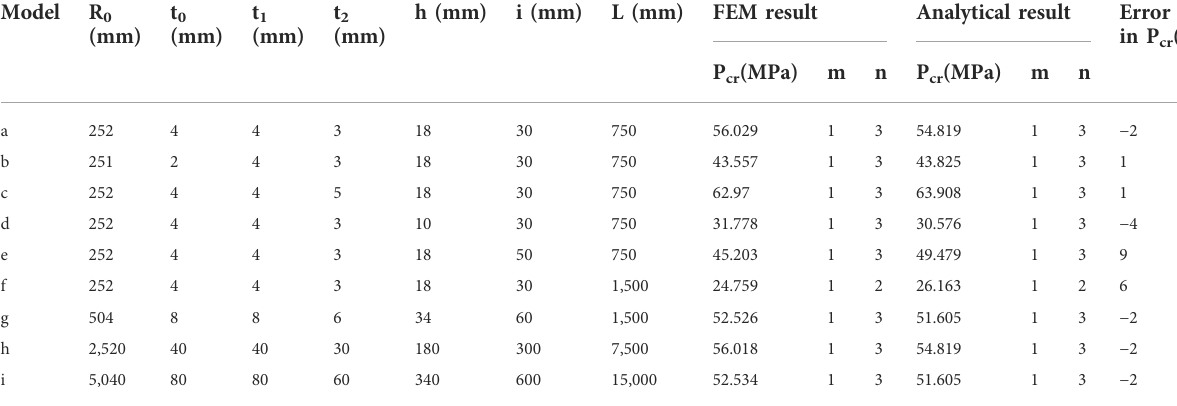
TABLE 2 Dimensions of models and comparison between FEM and analytical results.